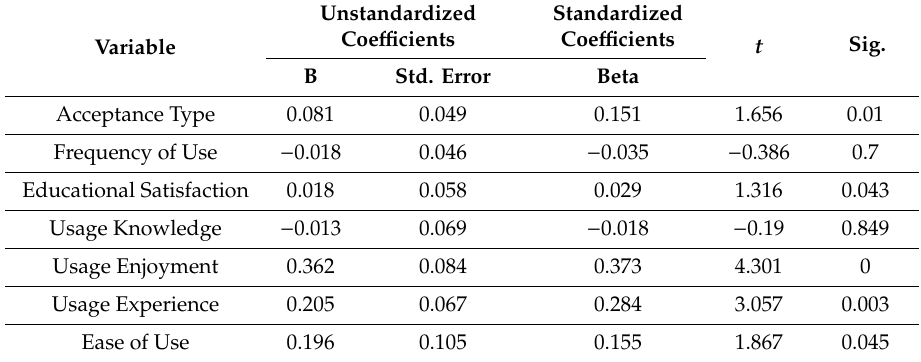
Table A2. Analysis result of internal variables and usefulness (dependent variable: